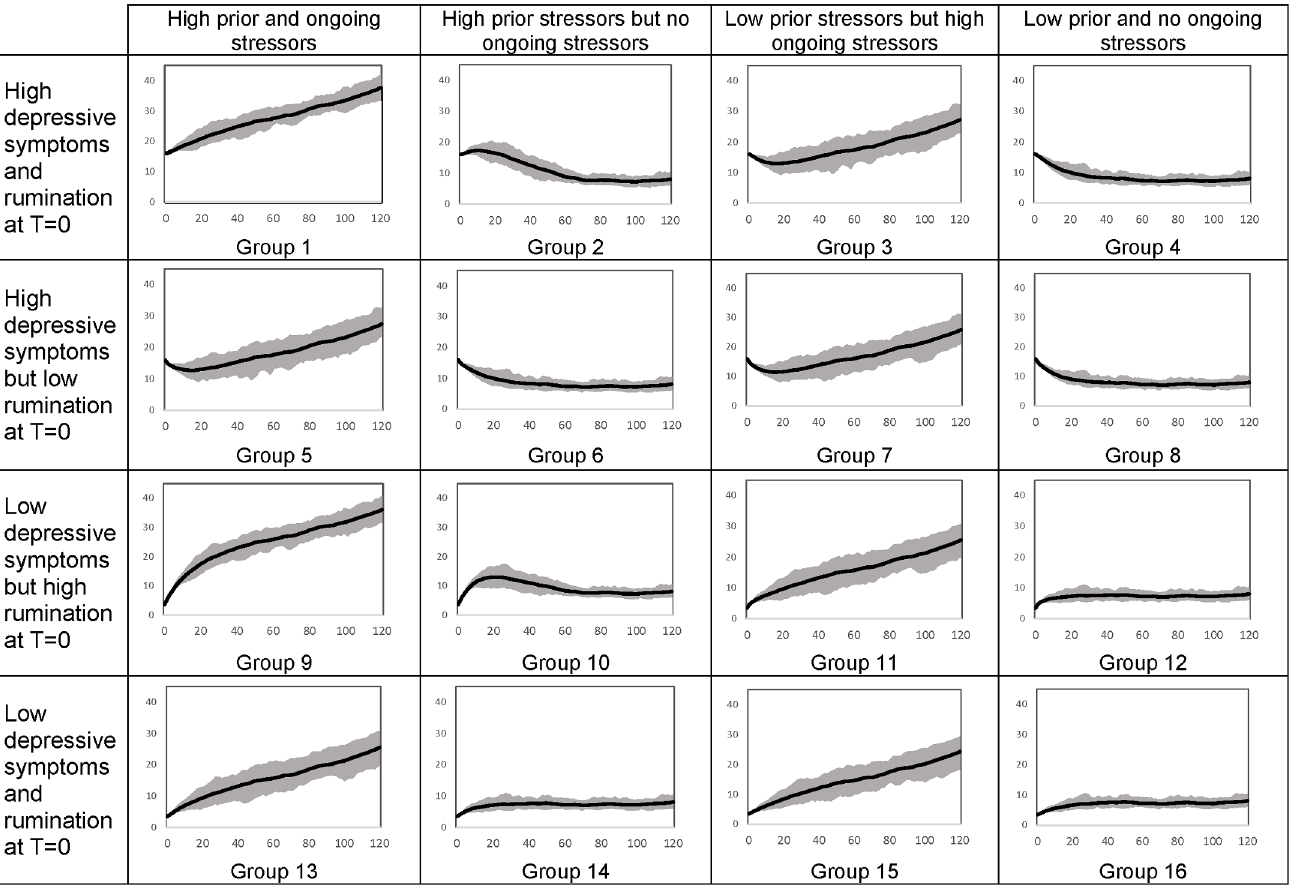
Fig 4. Simulated depressive symptoms over 120 months for 16 groups of girls with characteristics listed in Fig